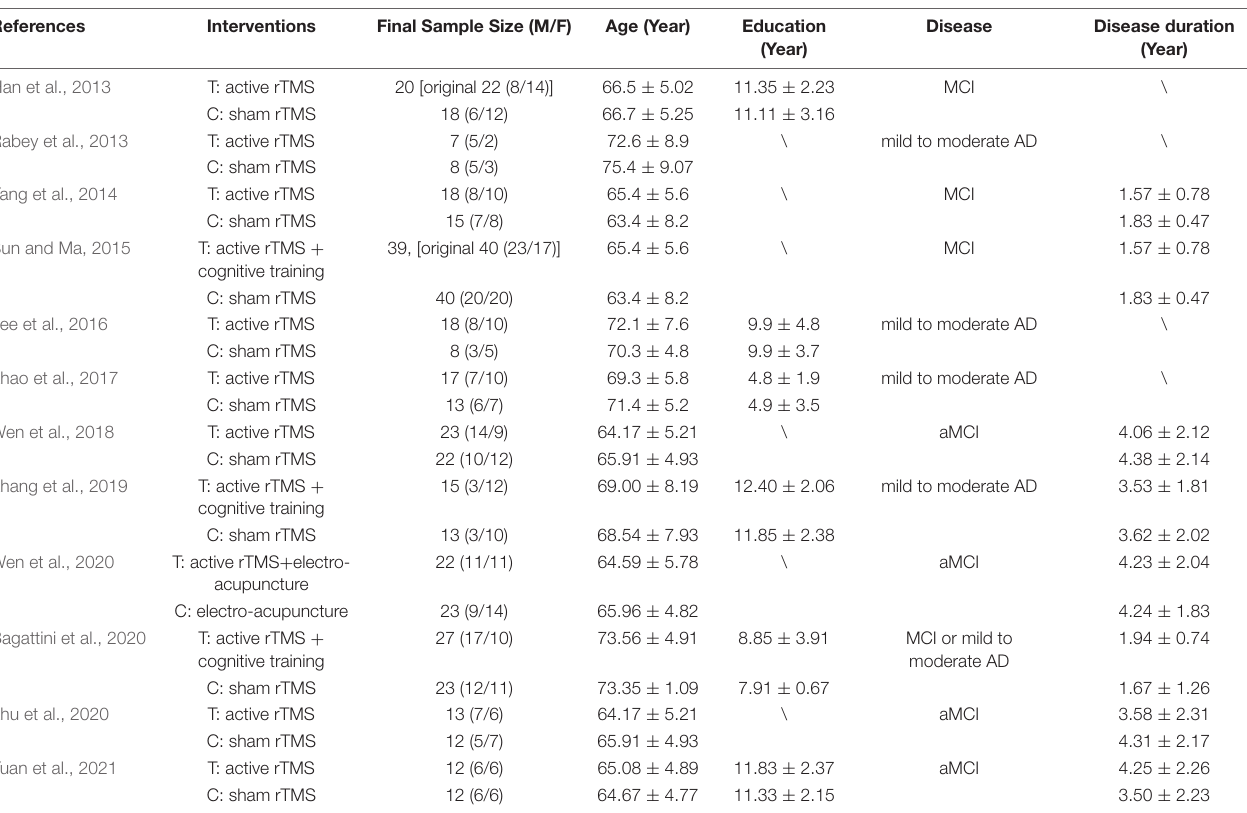
TABLE 1 | Demographic characteristics of the included